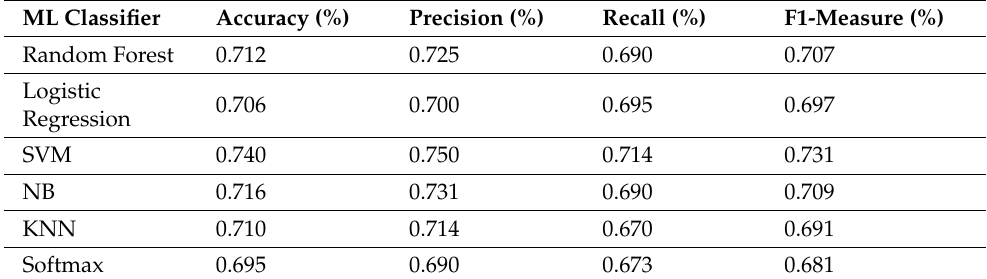
Table 3. Roman Urdu CNN-LSTM performance with various ML classifiers using UCL